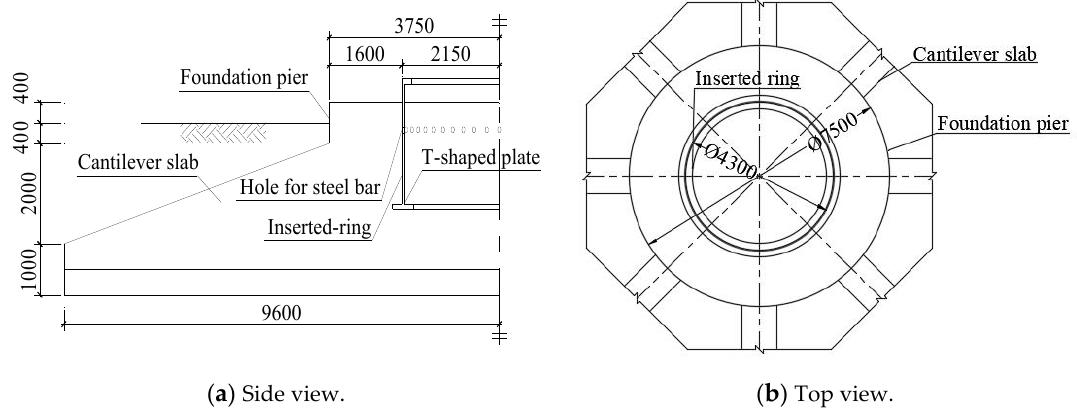
Figure 3. Structure of an embedded-ring foundation.